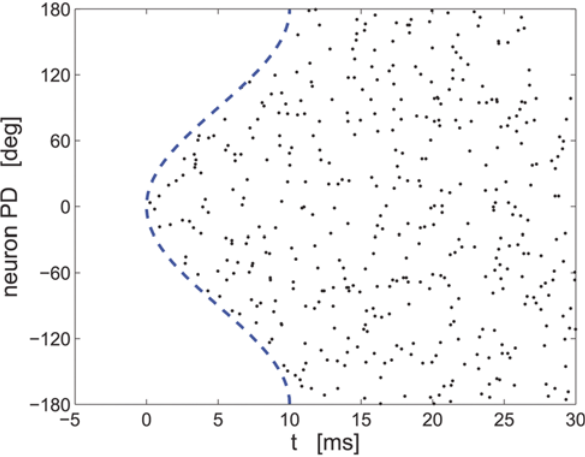
Figure 6. Simulation of a hypercolumn population raster plot. Spiking responses of 360 cells coding for an external stimulus h ~ 0 0 during a single trial are shown. Each line shows the spike-times of a single cell. The cells are arranged according to their preferred directions. Spike times of cell with preferred direction w was modeled by an IHPP with PSTH r t ð Þ ~ r H t { t w { h ð Þð Þ , where r ~ 50 Hz is the rate and the latency function is t Q ð Þ ~ 5 1 { cos Q ð Þ½ (cid:1) ms . The dashed line shows t w { h